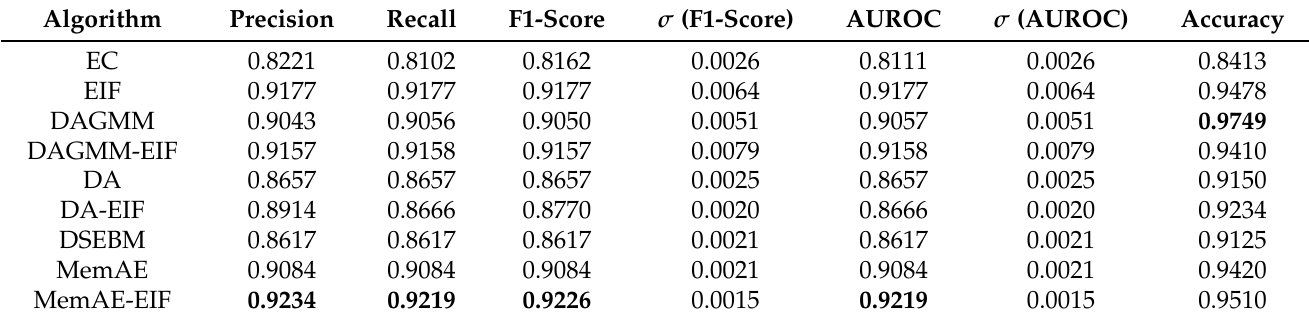
Table 1. Results obtained from testing unsupervised algorithms on the KDDCUP99 dataset.